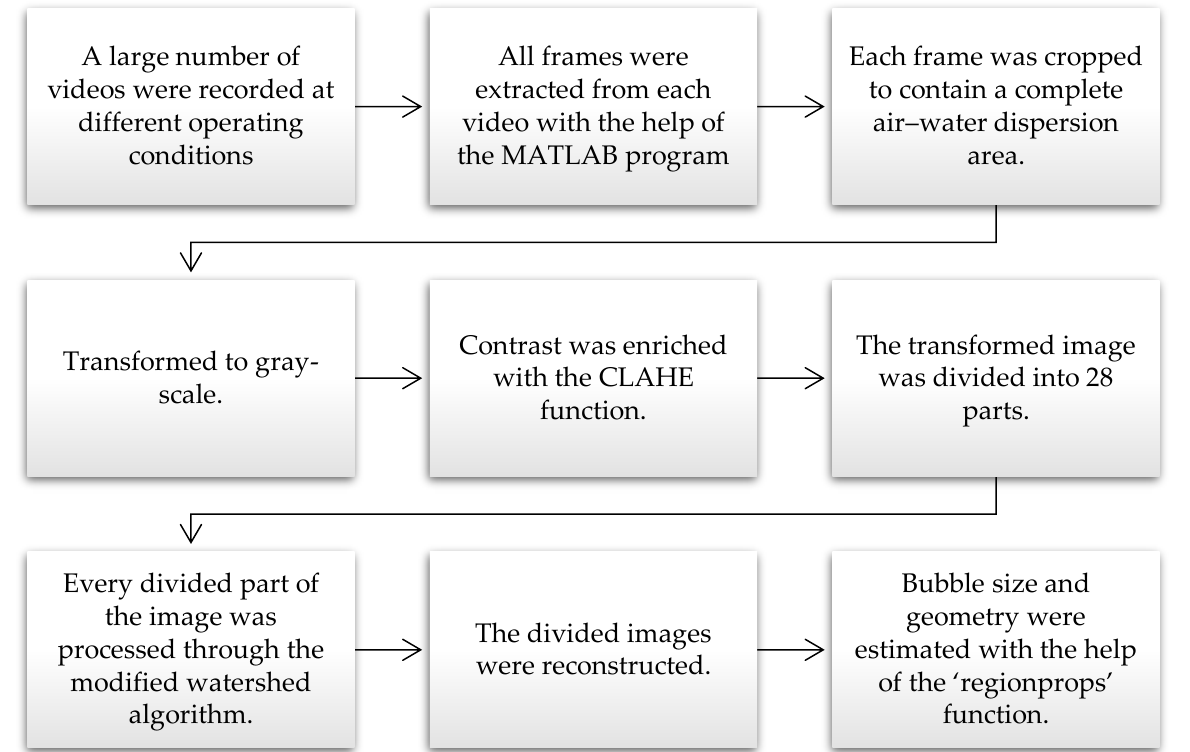
Figure 4. Steps for the IP algorithm applied for estimation of bubble characteristics .